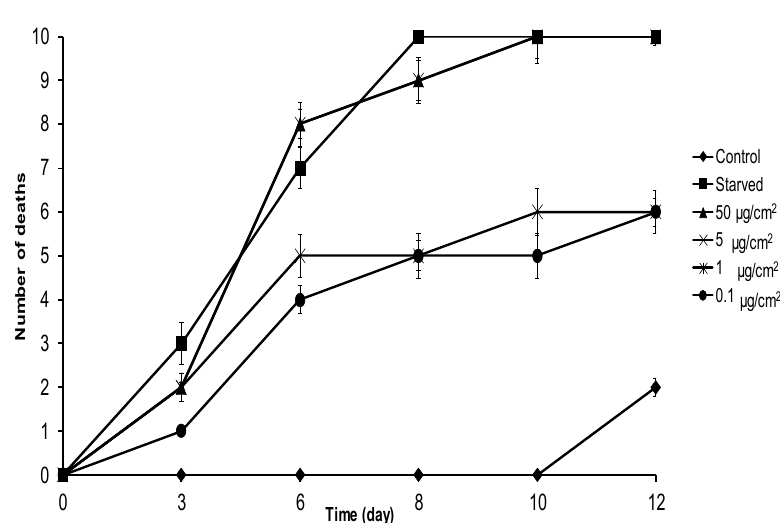
Figure 3. Cumulative mortality of S. frugiperda larvae fed with leaves treated with 1 at different concentrations. All treatments were in triplicate ( n = 10). Starved represents food-deprived treatment. Error bars show standard deviation; where error is not shown, it is smaller than the symbol.